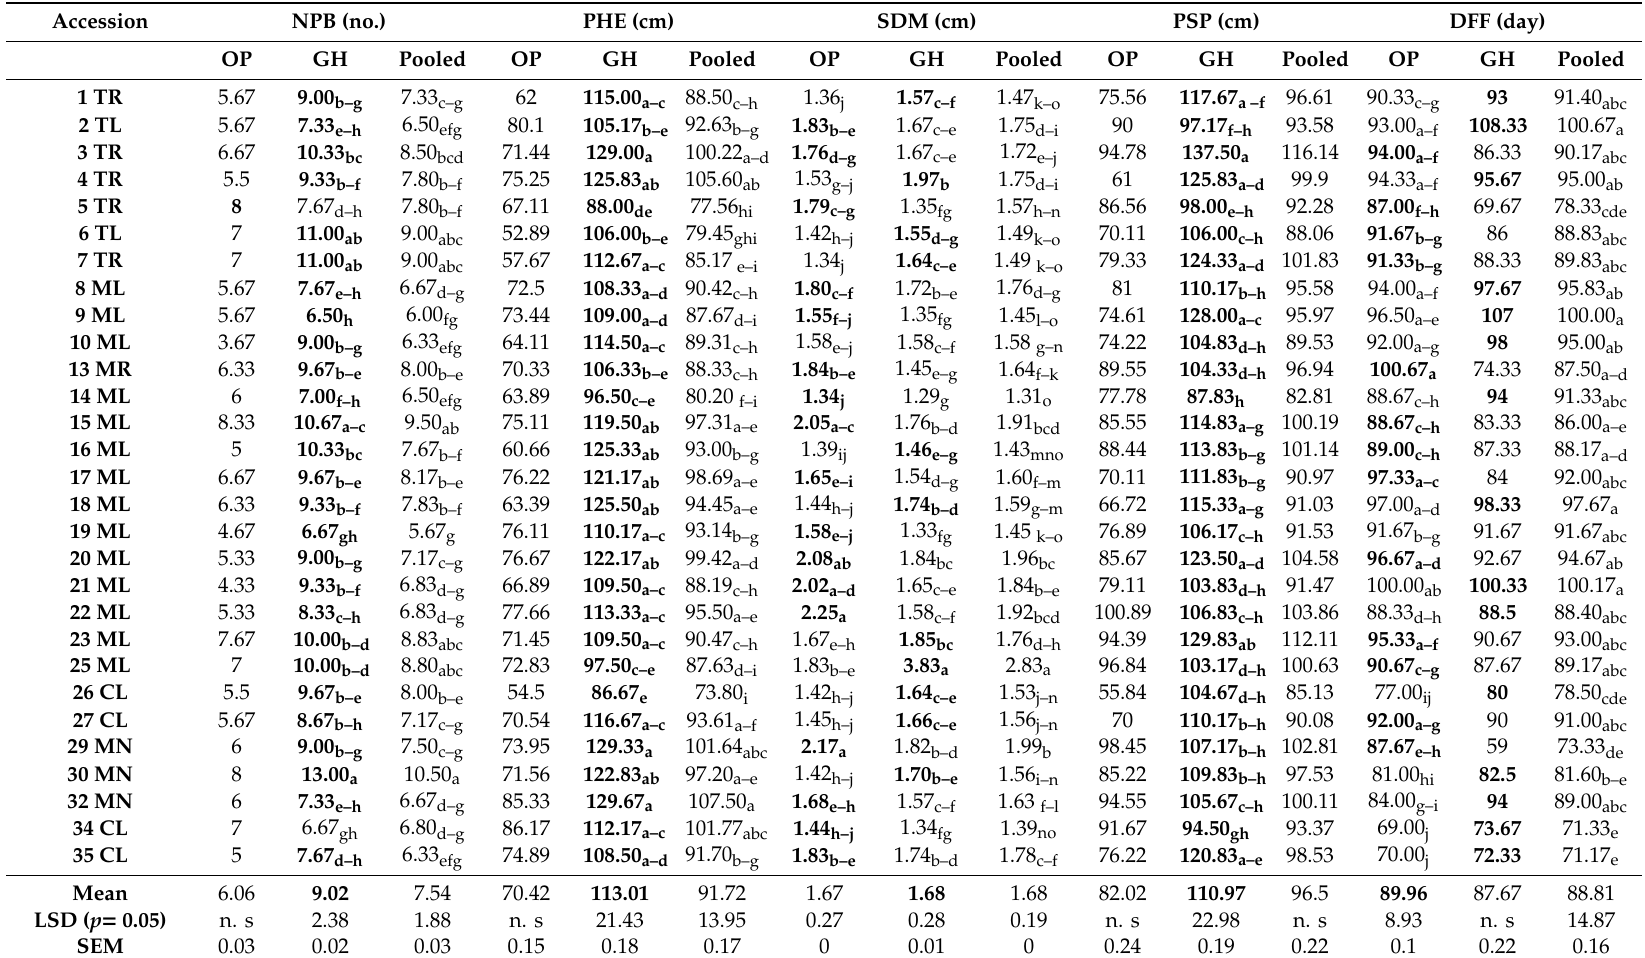
Table 5. Mea ns for vegetative characteristics studied in 29 accessio ns of eggplant across two cropping conditio